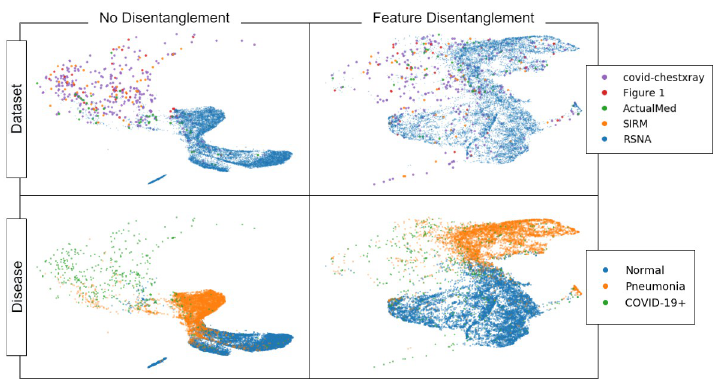
Fig 2. UMAP projections of features learned from models trained with and without feature disentanglement on unmasked imagery. Each point represents a CXR from the COVIDx dataset. The top row colors points by their domain label—which subdataset of the COVIDx dataset they are in—while the bottom row colors points by their disease label. We observe that without feature disentanglement, the learned representations easily separate datasets— despite not being trained for this task—however, with feature disentanglement, the learned representations do not clearly separate